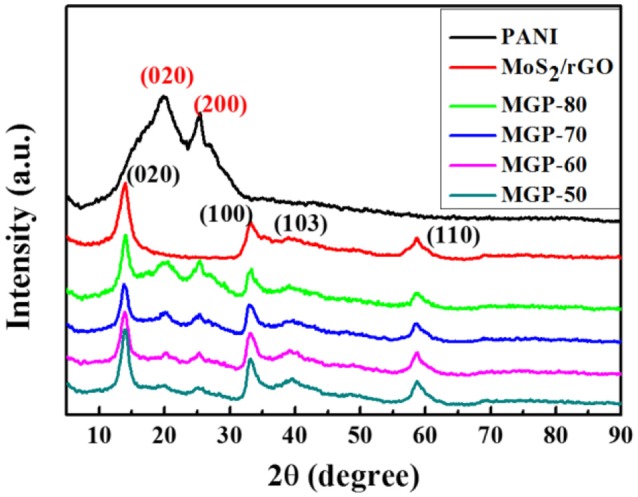
XRD patterns of the PANI, MoS2/rGO binary composite, and MoS2/rGO/PANI ternary composites.